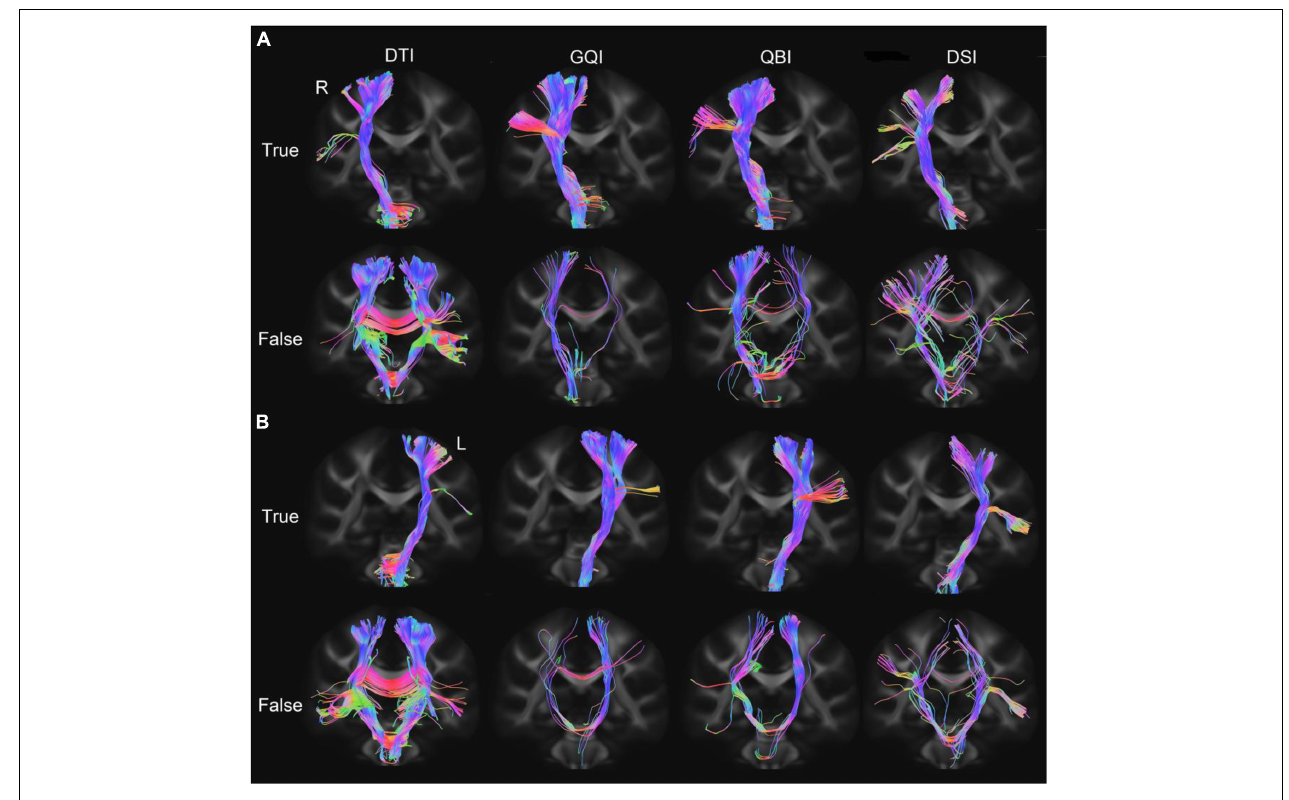
FIGURE 2 | PT fibers tracked based on four diffusion models. (A) The true and false fibers of the right PT. (B) The true and false fibers of the left PT. DTI, diffusion tensor imaging; DSI, diffusion spectral imaging; GQI, generalized Q-space sampling imaging; L, left; PT, pyramid tract; QBI, Q-ball imaging; R,